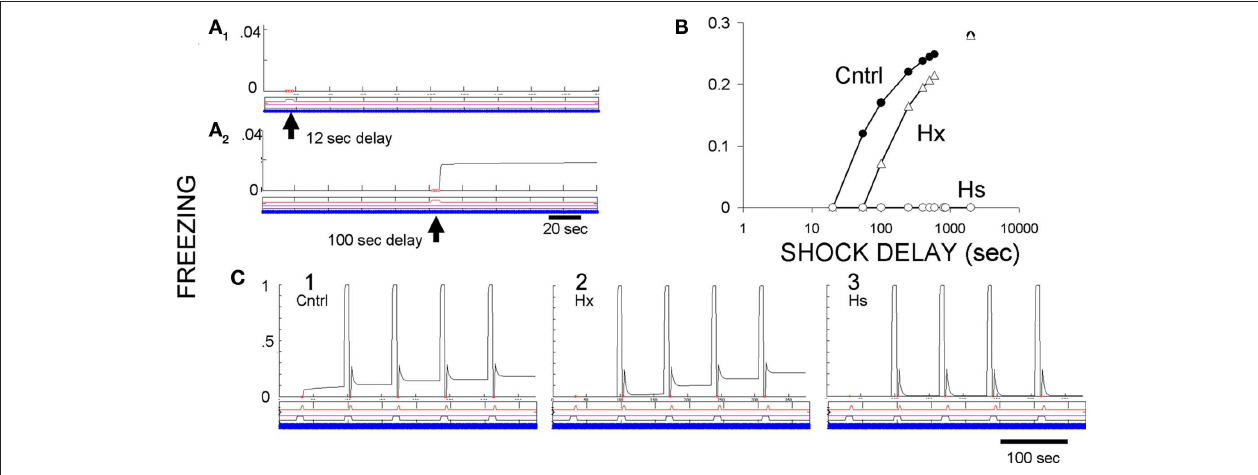
hippocampus-ablated (Hx) FRAT, and hippocampus-suppressed (Hs) FRAT. (C) CS and context conditioning under three conditions. (1) Control FRAT; CS fear is learned rapidly and context fear begins after the first US. (2) Hippocampus- ablated FRAT (Hx); context fear develops a little more slowly than in controls. (3) Hippocampus-suppressed FRAT that has been extensively exposed to the context prior to conditioning; cued fear but no context fear becomes